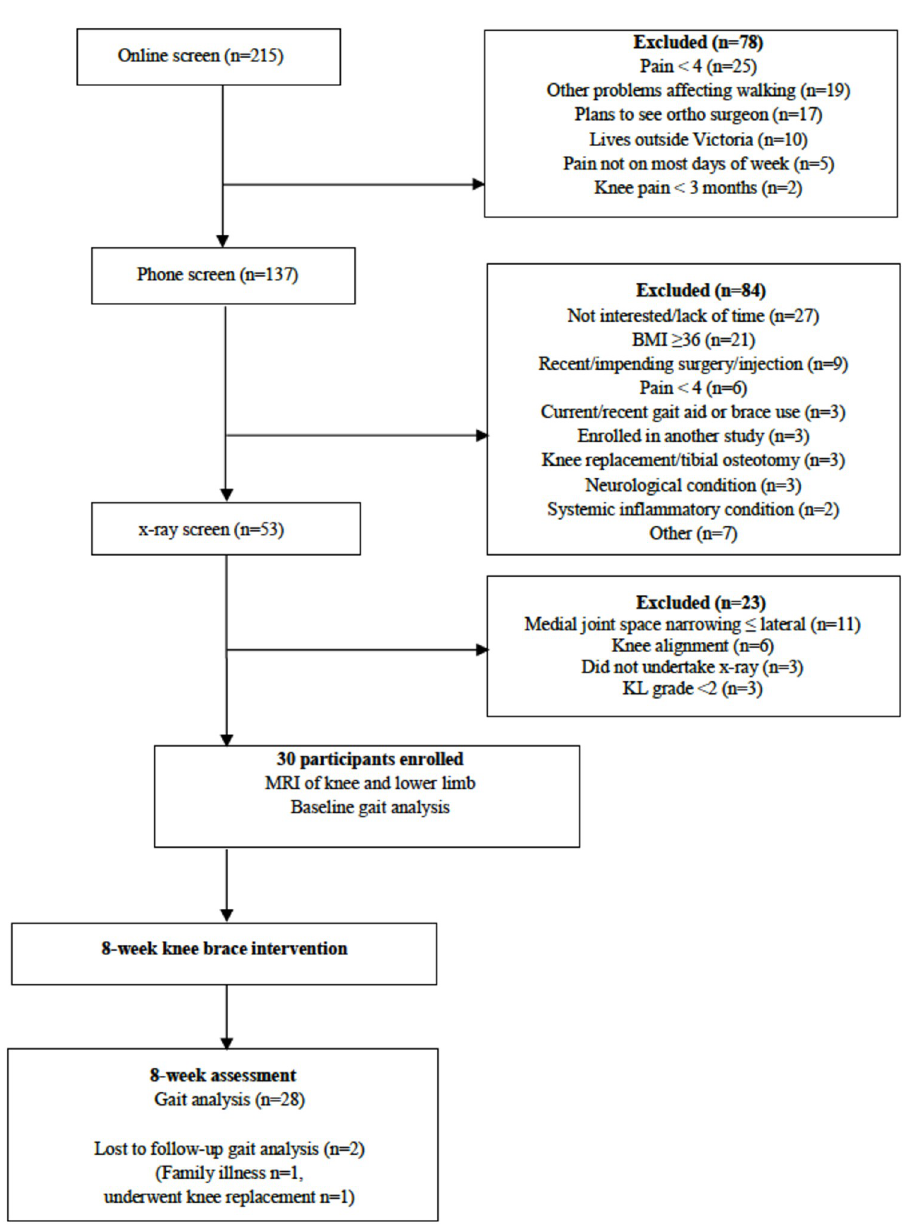
Fig 1. Flow of participants through the